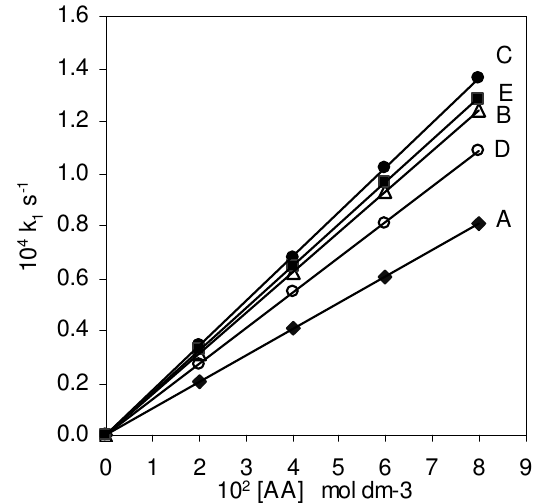
Figure 2 . Plots of [AA] versus k (A=Glycine; B=Alanine; C=Histidine; D=Arginine; 1 E=aspartic acid) Table 2 . Activation parameters for the oxidation of amino acids by NCSA a Parameters Glycine Alanine Histidine Arginine